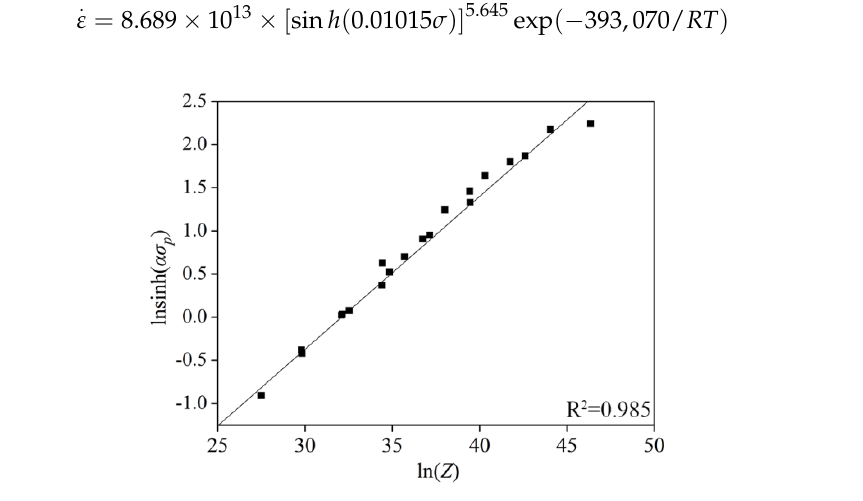
Figure 5. Relationship between peak stress and true strain and temperature: ( a ) lnsin h ( ασ p ) − ln ε ̇ , and ( b ) lnsin h ( ασ p ) − 1/ T.